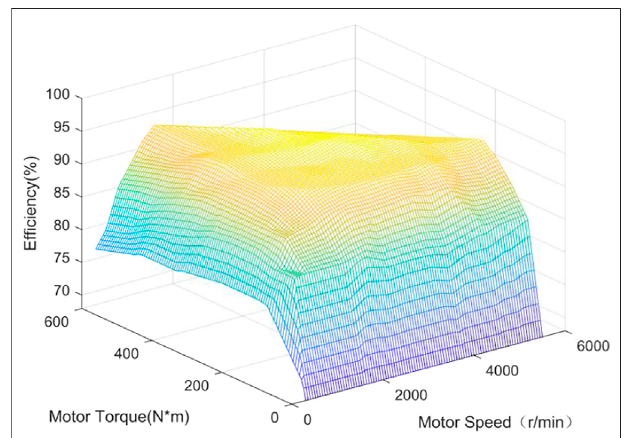
FIGURE 3 | MAP diagram of motor ef fi